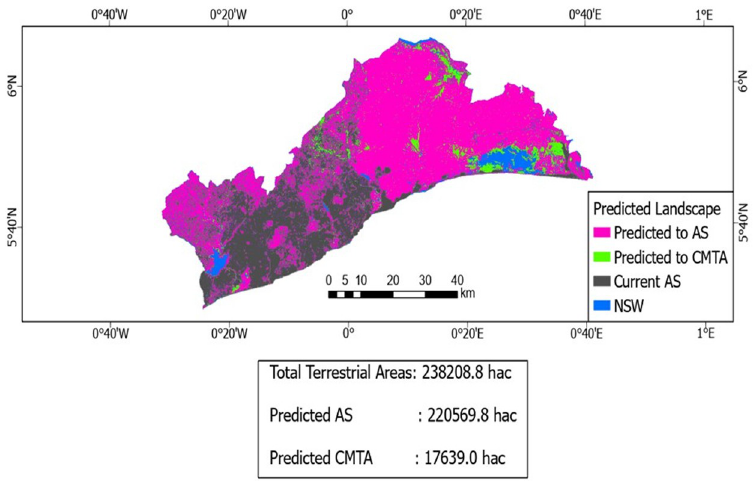
Fig 7. Future land cover for Greater Accra Region in business-as-usual scenario. Source: Authors’ construct with base map from